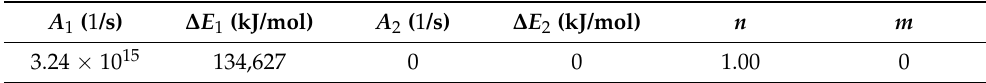
Table 6. Fitting parameters for the curing kinetics